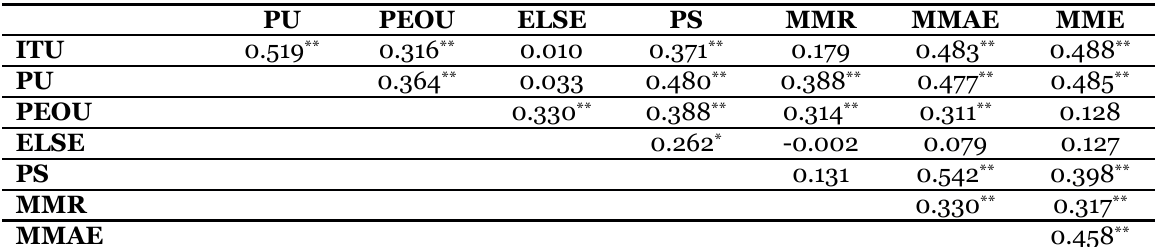
Pearson Correlation Coefficient Among Variables PU